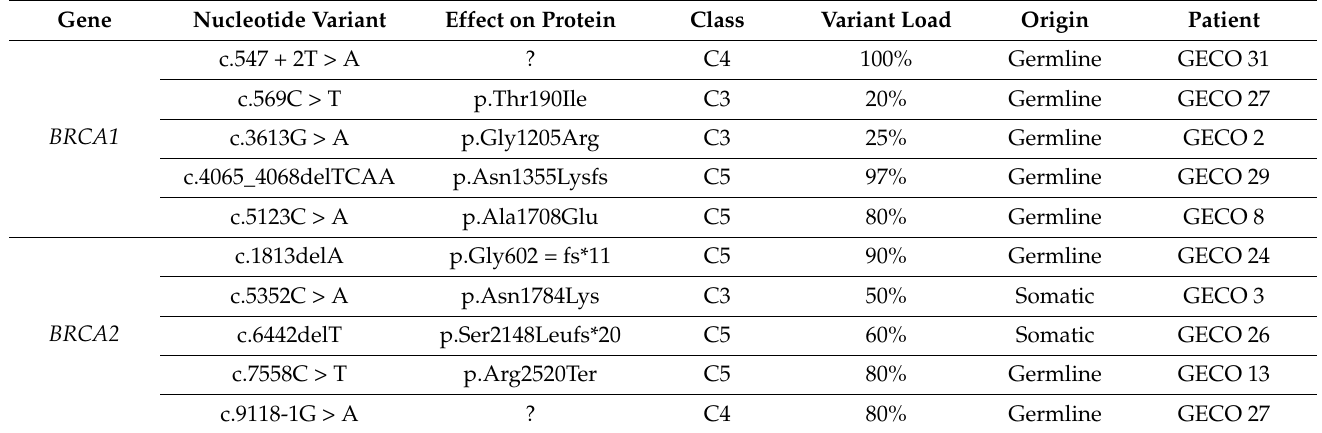
Table 1. BRCA1/2 sequence variants